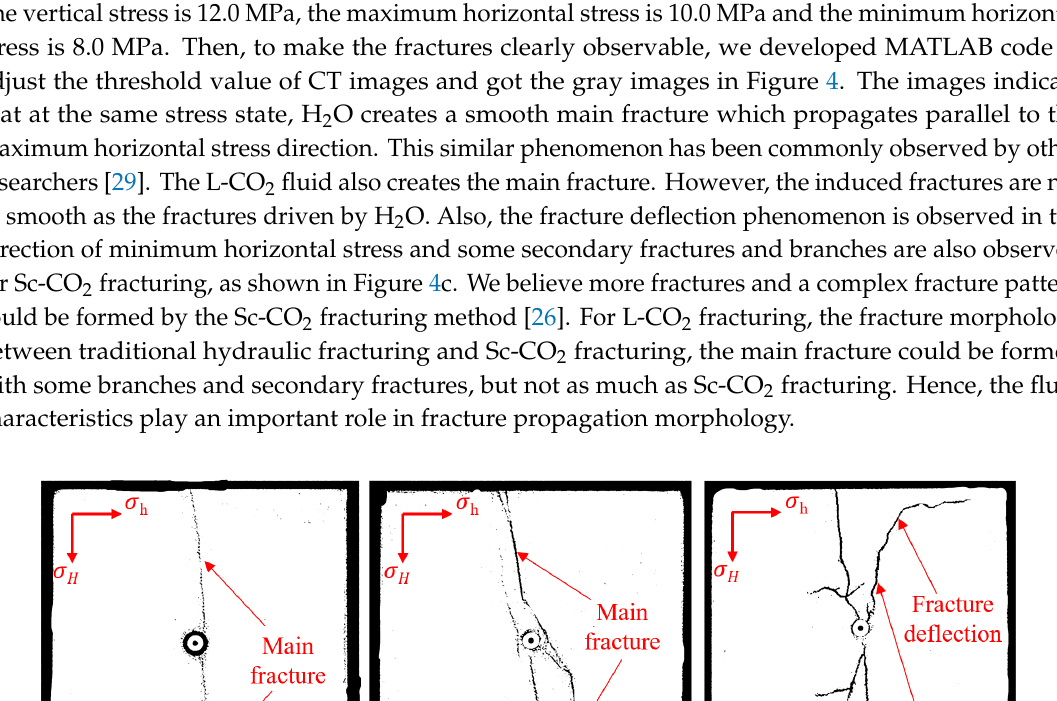
Figure 3. The relationship between fluid pressure and the elapsed time for all seven fracturing experiments.